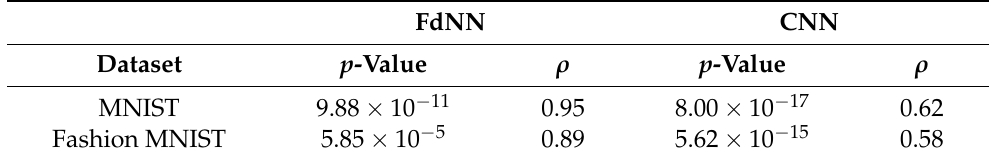
Table 9. Mean values for Spearman’s correlation test between number of hidden units and categorical accuracy for each simulation experiment regardless of the quantization